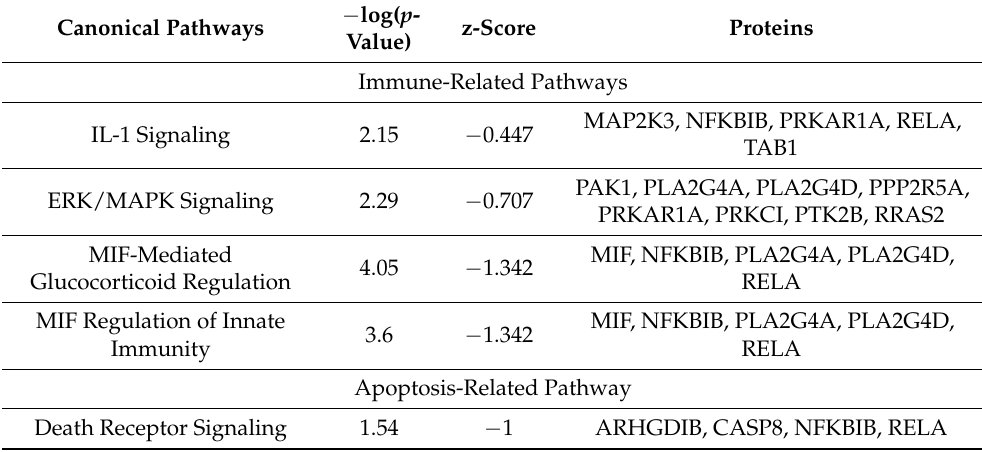
Table 4. Canonical pathways for the 400 µ g/mL of nicotine vs. PBS with negative z-scores.